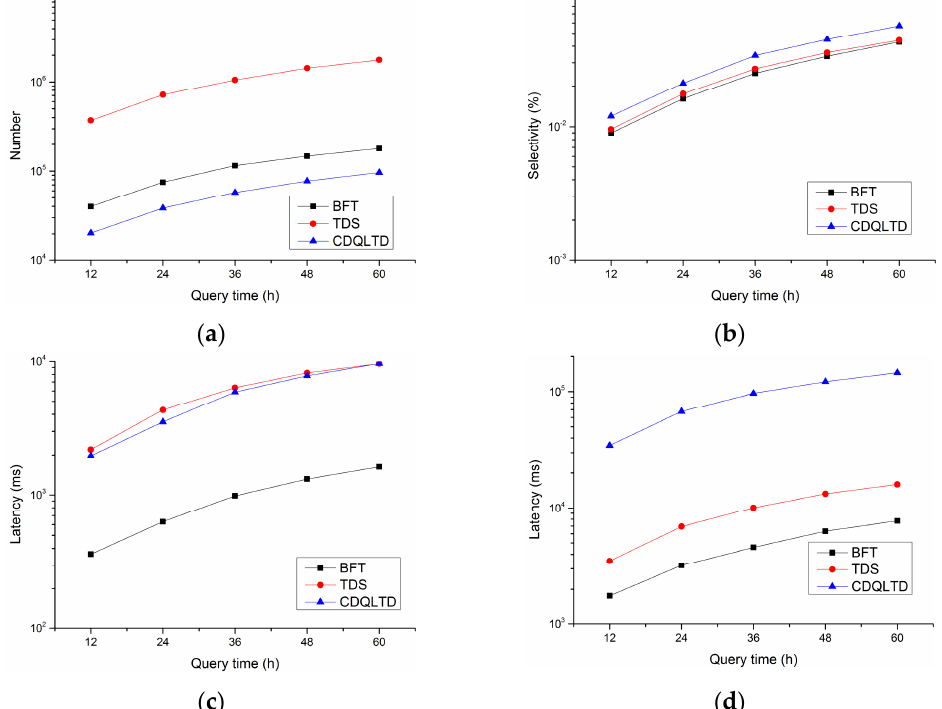
Figure 9. Performance of different time ranges: ( a ) Number of the accessed nodes, ( b ) selectivity, ( c ) pruning latency, ( d ) query latency.